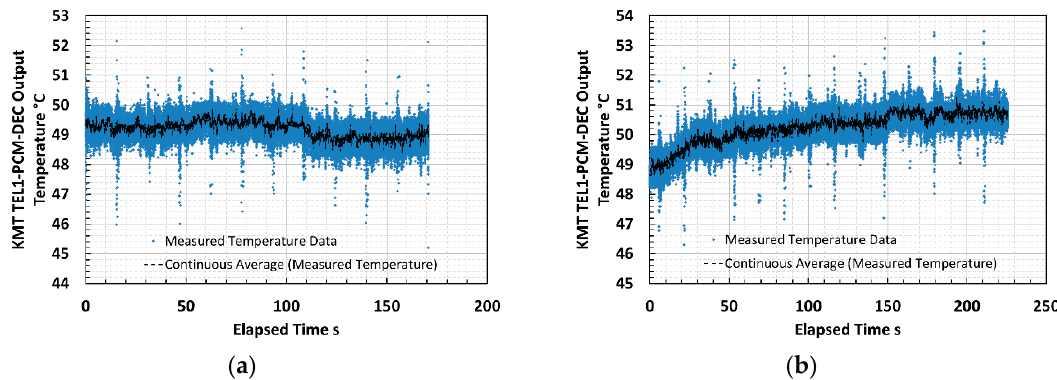
Figure 13. Cutting tool insert temperature recorded by fiber optic thermometer on ( a ) first cutting pass at minimum temperature measurable and ( b ) second cutting pass illustrating marginal temperature increase during milling trials.